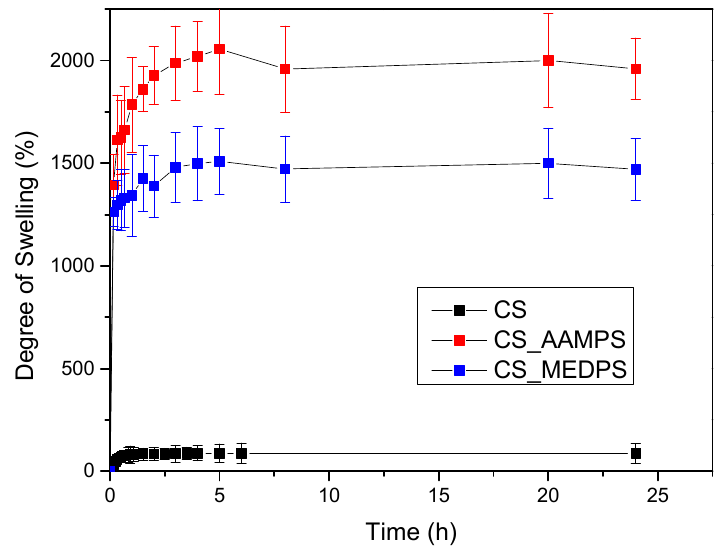
Figure 4. Degree of swelling versus time for CS, CS-AAMPS and CS-MEDPS at pH = 7.